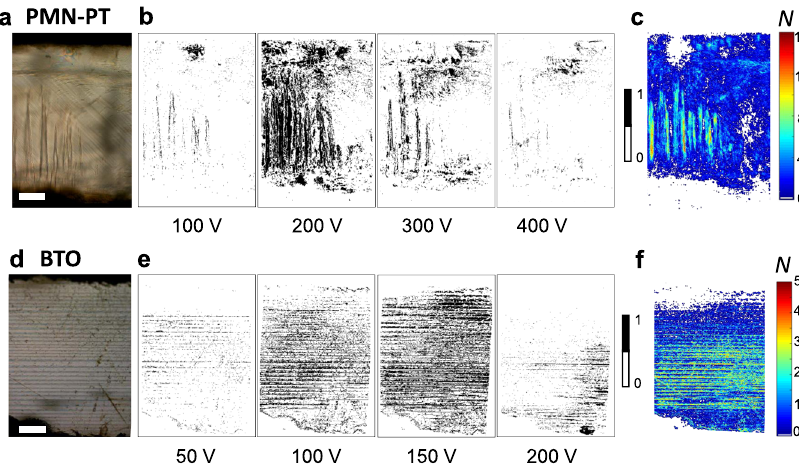
Fig. 1 Localization of avalanches for PMN-PT and BTO. Optical image of the initial state of the sample for a PMN-PT and d BTO. The scale bar indicates 200 µ m. Switched regions for b PMN-PT and e BTO, at representative applied voltages. The black regions (assigned to 1) are regions that switched between t and t + δ t , with δ t = 1/30 s, while the white regions (assigned to 0) remained unchanged. Accumulated activity maps after a full hysteresis loop for c PMN-PT and f BTO. The colour scale indicates the number of times each pixel (~1 µ m 2 in size) has been